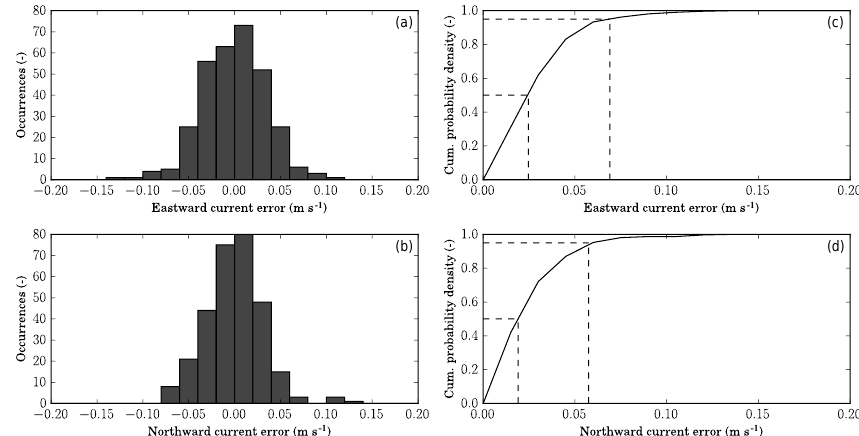
Figure 5. Errors in the estimated currents. Upper left panel: histogram for eastward direction; bottom left panel: histogram for northward direction; upper right panel: estimated probability density function for eastward current; and bottom right panel: estimated probability density function for northward current. The dashed lines indicate the 50 and 95%